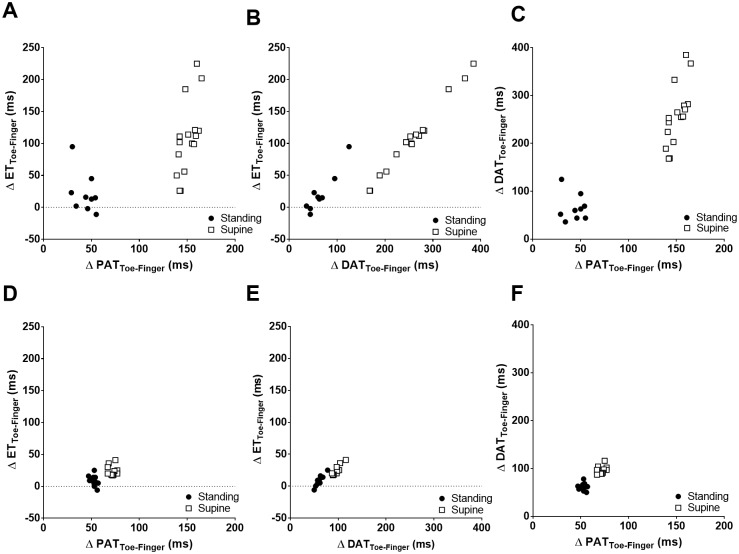
Relationship between ΔETToe-Finger, ΔPATToe-Finger and ΔDATToe-Finger in an individual subject.(A), (B), and (C) Measurements derived from a 23 year old female with the most compliant vasculature as evident by the lowest PWVΔPAT Toe-Finger in the supine position. (D), (E), and (F) Measurements derived from a 36 year old female with the least compliant vasculature as evident by highest PWVΔPAT Toe-Finger in the supine position. Each dot on the graph was derived from a single heartbeat in the standing (black circles) and supine (white squares) positions. (A) and (D) Scatter plot of ΔETToe-Finger and ΔPATToe-Finger. (B) and (E) Scatter plot of ΔETToe-Finger and ΔDATToe-Finger. (C) and (F) Scatter plot of ΔDATToe-Finger and ΔPATToe-Finger. ET: ejection time; PAT: pulse arrival time; DAT: dicrotic notch arrival time, PWV: pulse wave velocity.